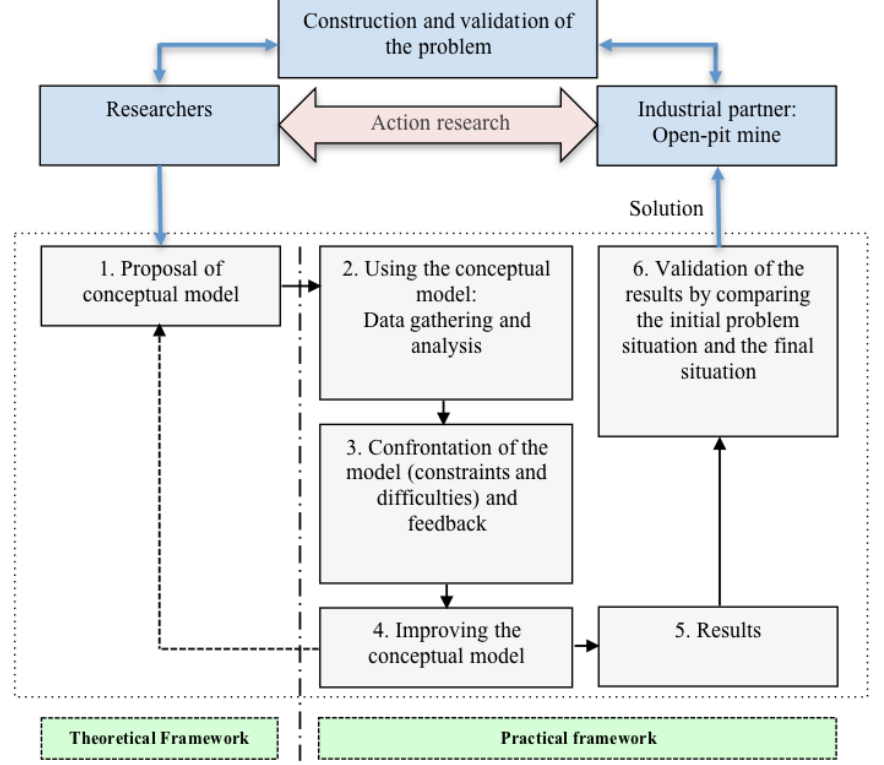
Figure 1. Methodology of application and validation of the proposed